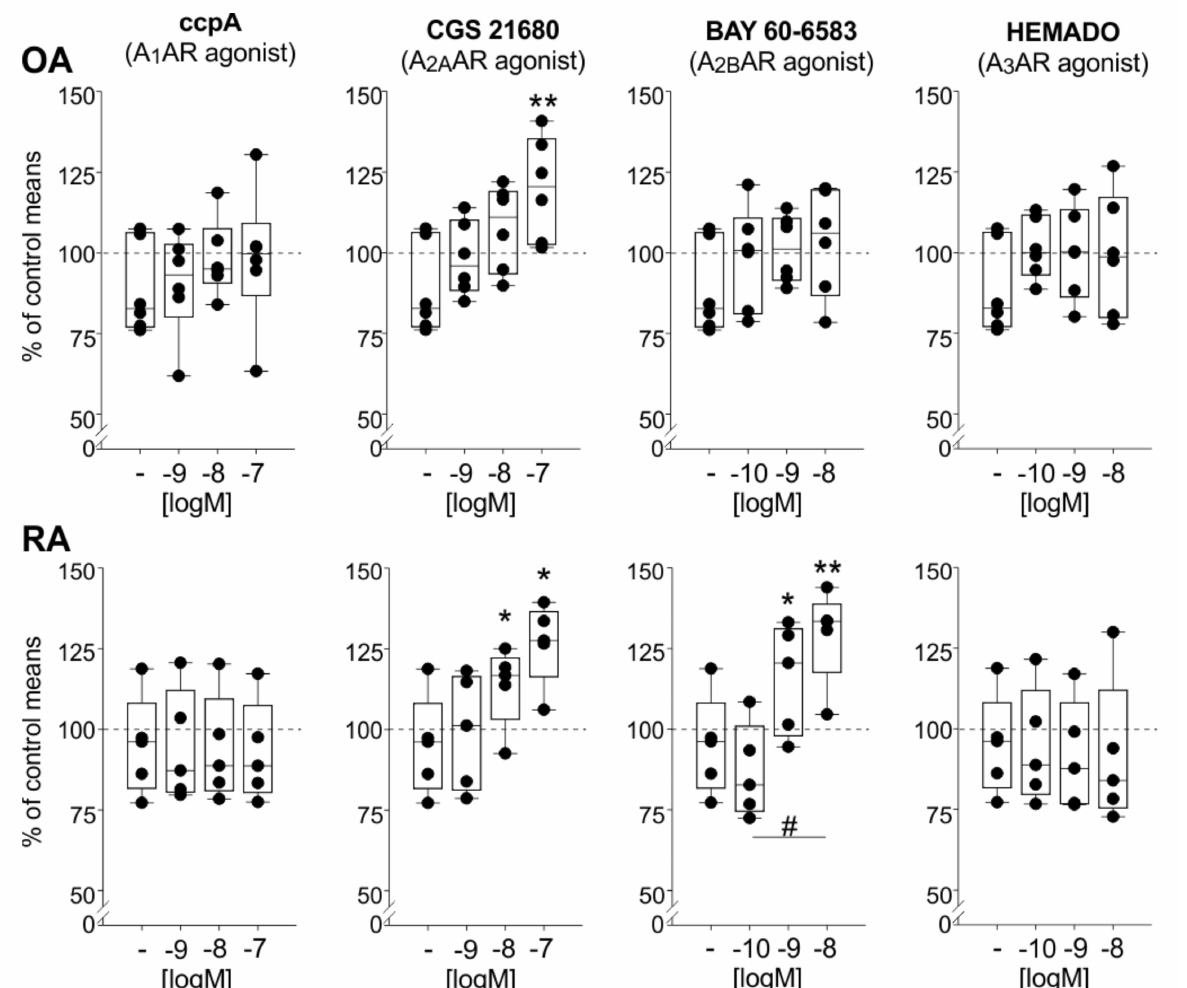
Figure 7. IL-10 release in OA and RA mixed synoviocyte cultures after activation of individual adenosine receptor subtypes by applying different AR agonists. Data are represented as box plots (as explained in the legend of Figure 1) ( n = 5–6). Values are expressed as percent of untreated control (untreated control is represented as “-“; the mean of untreated controls is represented as dashed line = 100%). Significant p -values compared to untreated control are presented as * p ≤ 0.05 ** p ≤ 0.01 when compared to untreated controls or as # p ≤ 0.05 when two treatment groups were compared. Abbreviations: see legend to Figure